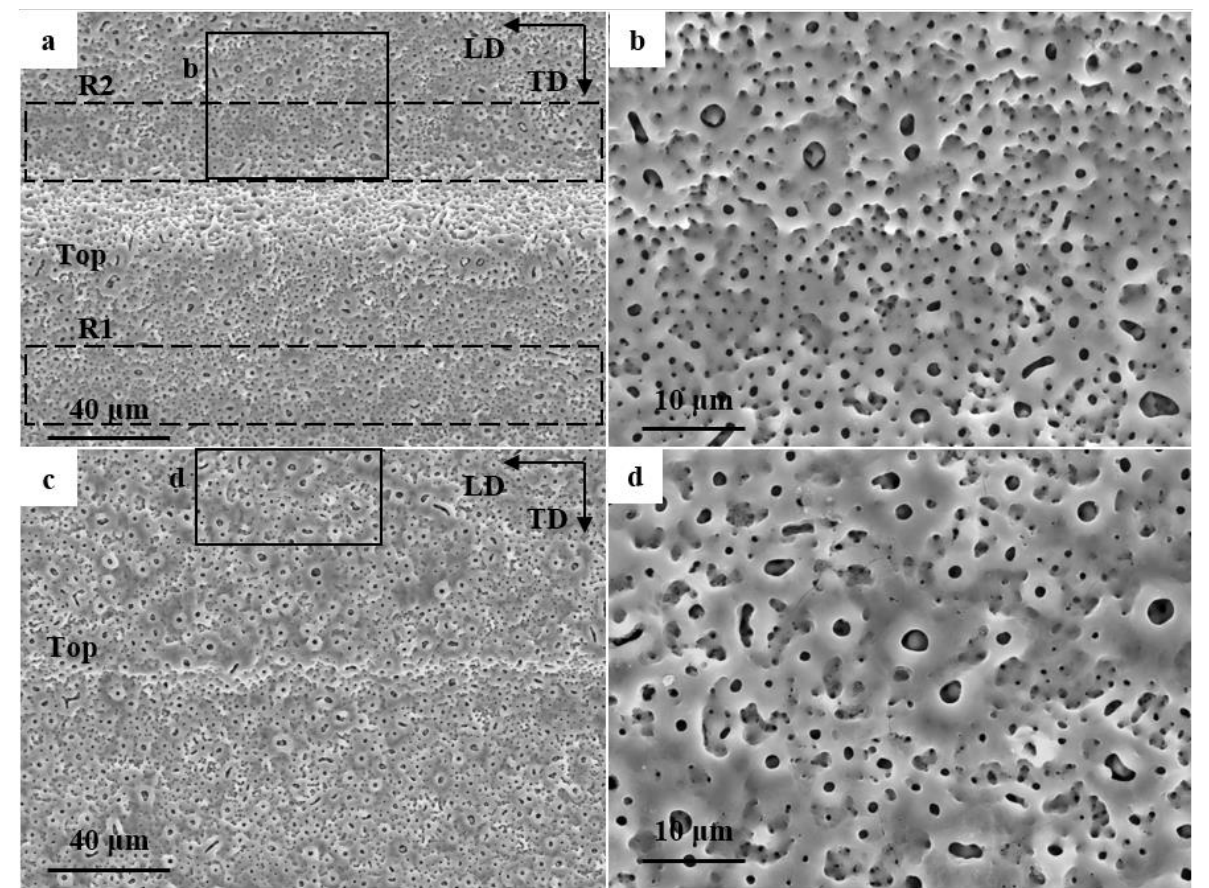
Figure 9. SEM surface of G1-PEO ( a , b ) and G2-PEO ( c , d ) samples. Dashed regions R1 and R2 in image a mark the regions analyzed for porosity in Table 3.